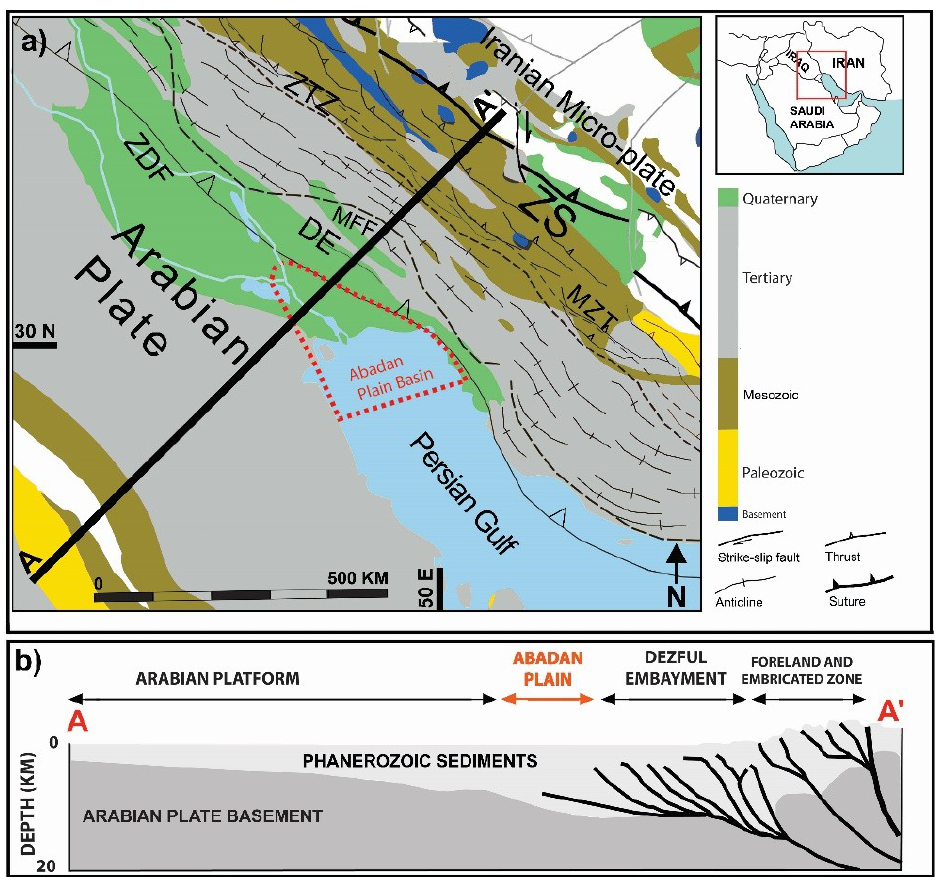
Figure 2. ( a ) Simplified geologic map of the Arabian Plate and Zagros Fold-Thrust-Belt based on Reference [24]. Tectonic features are from Reference [19]. Abbreviations: DE: Dezful Embayment (the region between the Abadan Plain Basin and MFF), MFF: Mountain Front Flexure, MZT: Main Zagros Thrust, ZTZ: Zagros Thrust Zone, ZDF: Zagros Deformation Front, ZS: Zagros structure. Abadan Plain Basin is bounded by the Zagros front fault to the north and north-east. The location of section A–A’ is also indicated. ( b ) Simplified cross-section across the Arabian Shield, Arabian Platform and the ZFTB along line A–A’ modified from Reference [9].